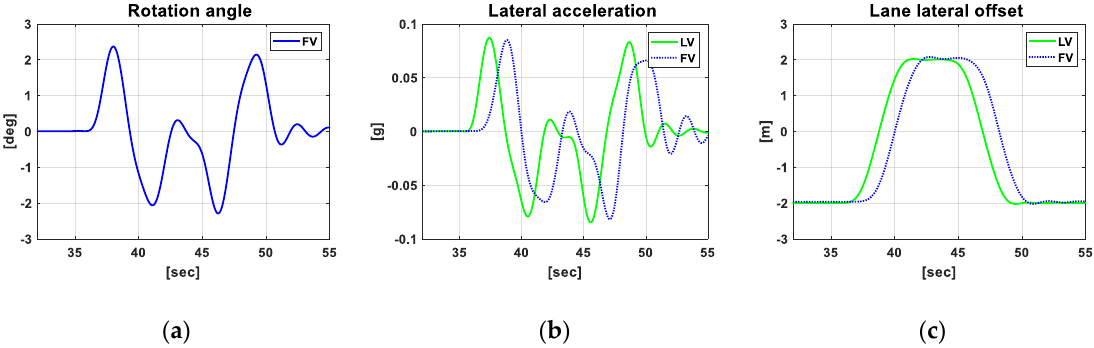
Figure 21. The simulation results for Scenario S3. ( a ) Rotation angle for point matching; ( b ) Lateral acceleration; ( c ) lateral offset of the vehicle with respect to the center of the lane.